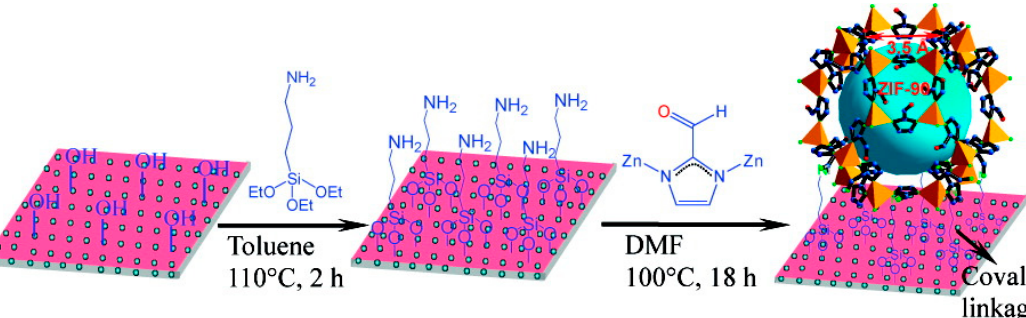
Figure 6. Scheme for preparing ZIF-90 membranes using 3-aminopropyltriethoxysilane (APTES) as a covalent linker between a ZIF-90 membrane and an Al 2 O 3 support via an imine condensation reaction (adapted with permission from ref. [82]).